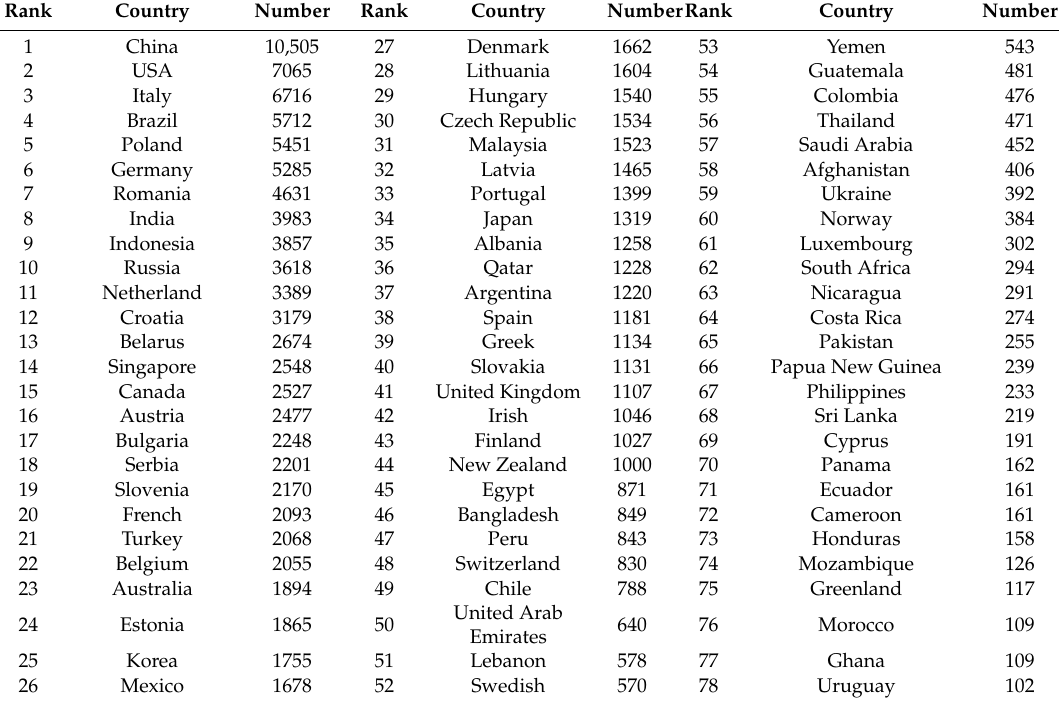
Date source: see note 1. Table 3. Ranking of countries with more than 100 FSC